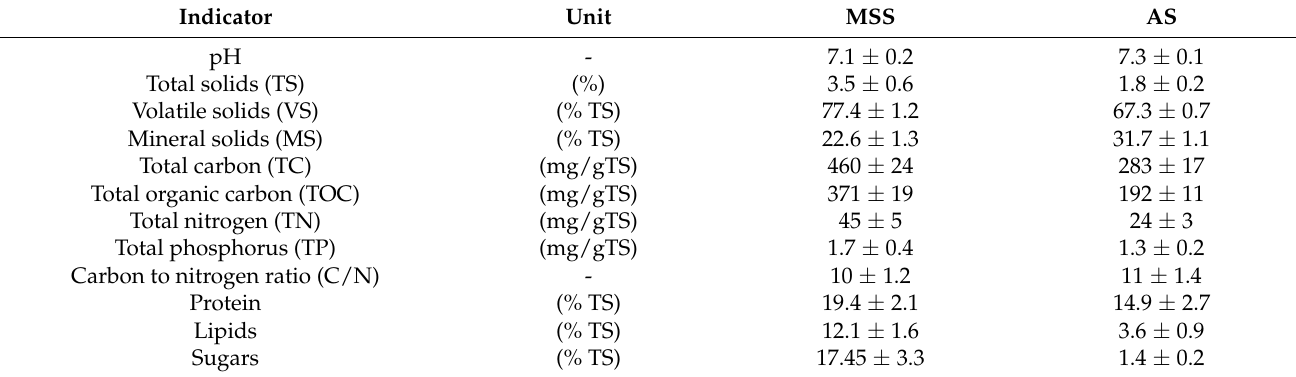
Table 2. Characteristics of the municipal sewage sludge (MSS) and anaerobic sludge (AS) used in the